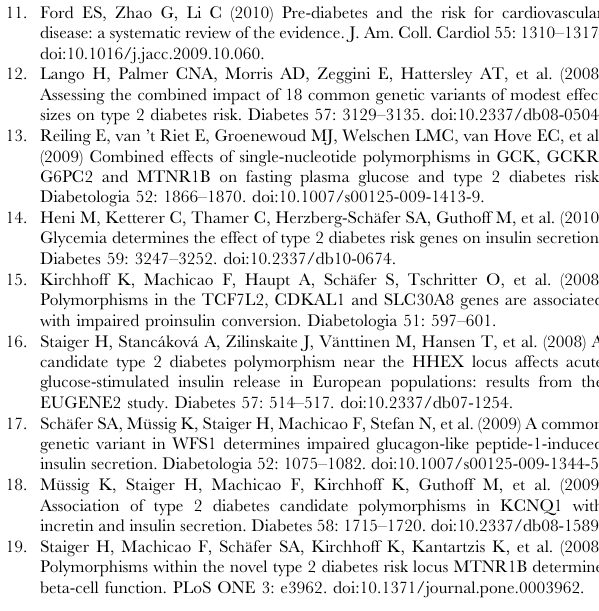
Table S1 Calculation of the genetic risk score. a For the FTO gene, rs8050136 was genotyped which is in complete linkage disequilibrium with